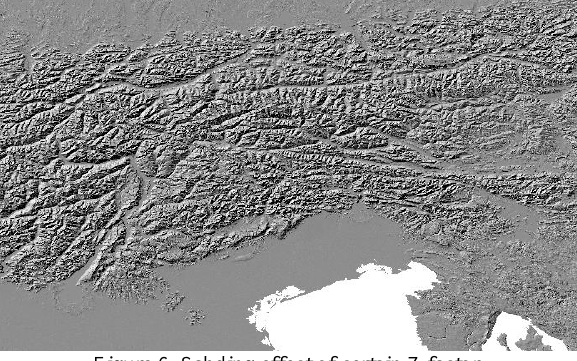
Figure 6. Sahding effect of certain Z